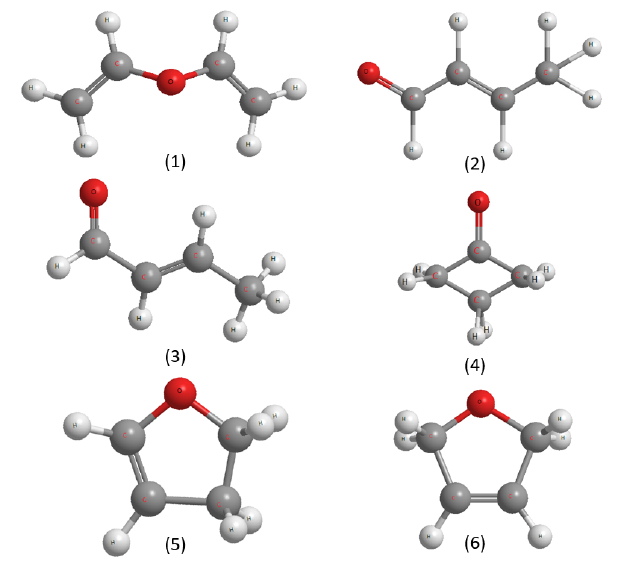
Figure 1. The structure of the targets: ( 1 ) vinyl ether, ( 2 ) 2-butenal, ( 3 ) cis-2-butenal, ( 4 ) cyclobutanone,